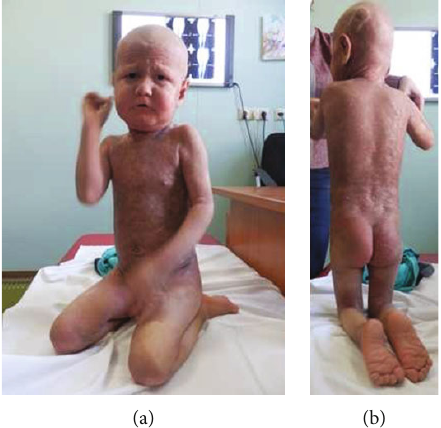
Figure 1: (a, b) The girl at admission; she manifested extensive lesions of the whole body (hyperkeratosis, erythroderma, alopecia totalis, lack of eyebrows and eyelashes, and characteristic wrinkled forehead) (a). Musculoskeletal examination showed fi xed fl exion contracture of the knees. At this stage, the child was unable to extend the knees and she could only crawl (b).